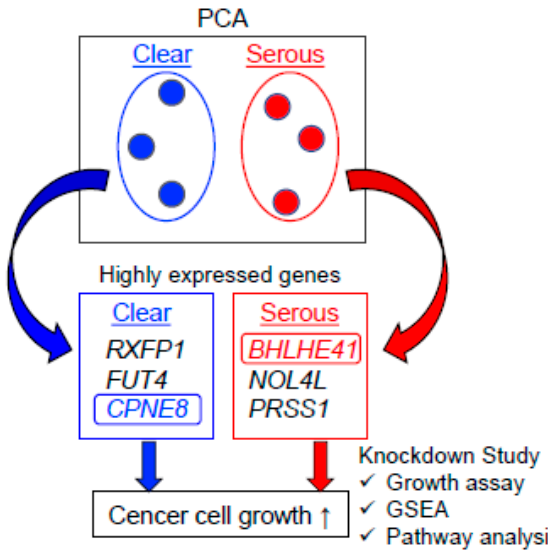
Figure 6. Schema of the present study. PCA based on mRNA levels analyzed by RNA sequencing was conducted in CCC and HGSC groups. The top three most highly expressed genes were chosen from the genes contributing to the first principal component of PCA in CCC and HGSC. Knockdown experiments for the selected genes showed that CPNE8 and BHLHE41 promoted the proliferation of CCC- and HGSC-derived cells, respectively. Functional enrichment and pathway analyses also showed that these two genes were related to cancer cell growth signaling.